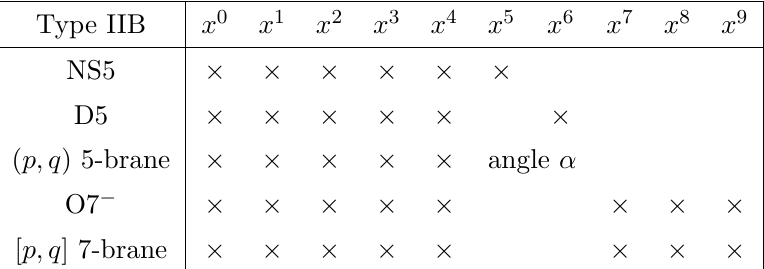
indicates the space-time directions (cid:2)